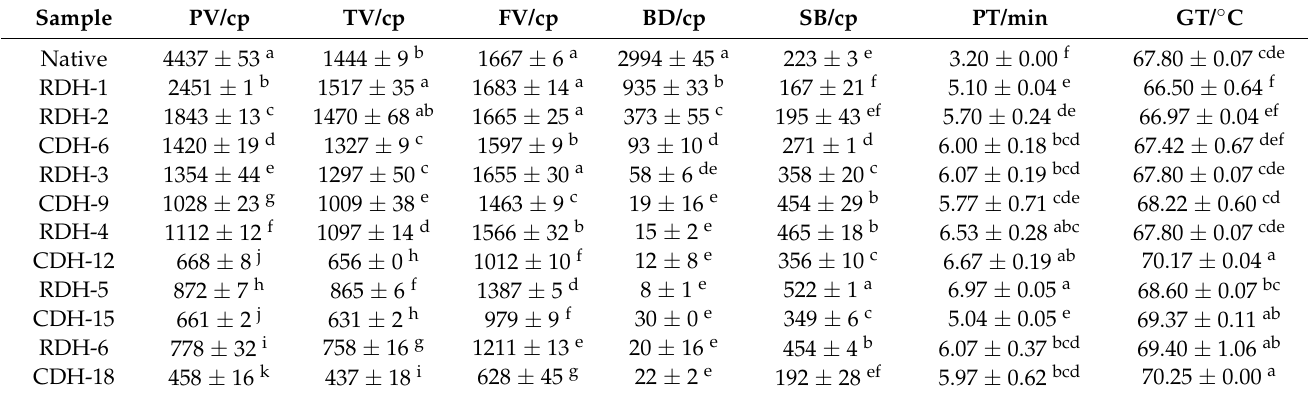
Table 2. Pasting parameters of the native, CDH- and RDH-treated potato starch